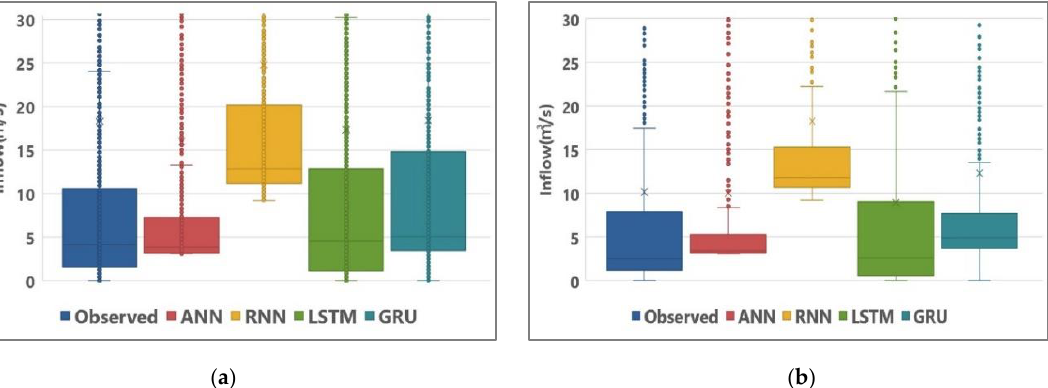
Figure 8. Comparison of predictions and observations for inflow ranges to Imha Dam. ( a ) Total period. ( b ) Drought period. Table 8. Inflow prediction by period at Imha Dam.